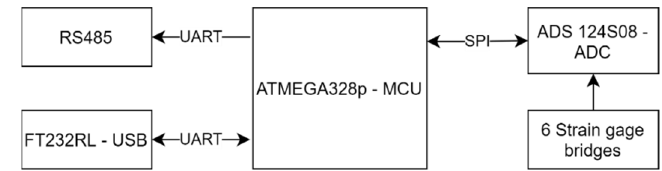
Figure 9. Diagram block of integrated DAQ.